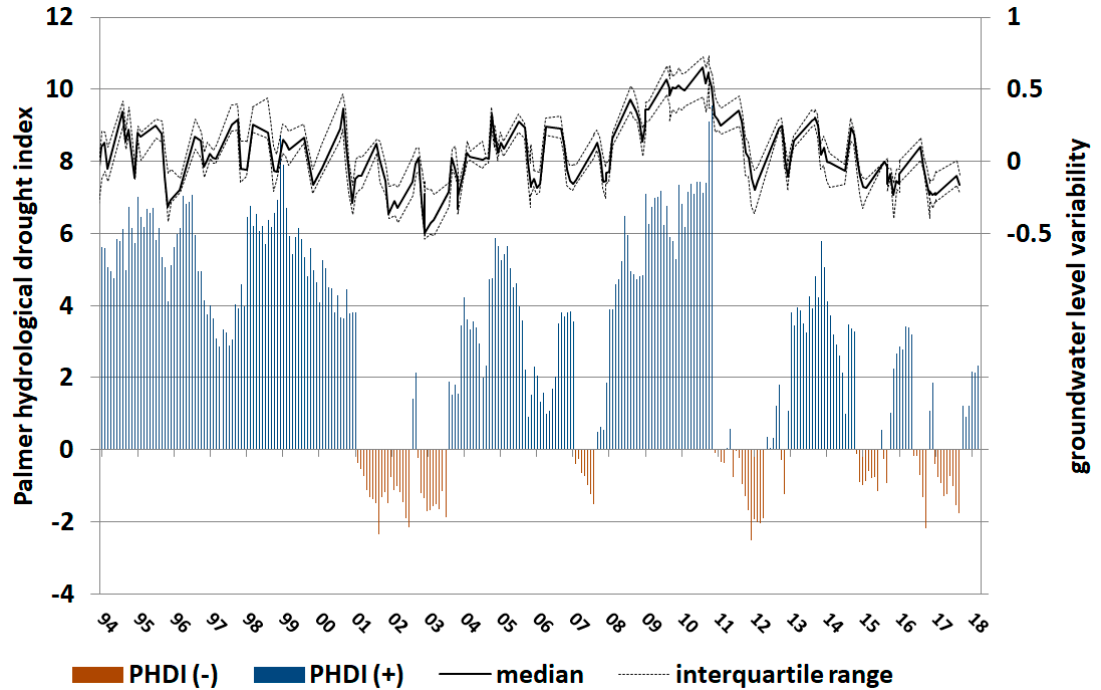
Figure 9. Palmer hydrological drought index for the southeastern North Dakota climate subdivision for September 1994 through October 2018 (horizontal axis) The secondary y-axis shows the normalized groundwater variability for 40 shallow wells in the unconfined aquifer. (Solid line is the median and dashed line brackets the interquartile range).